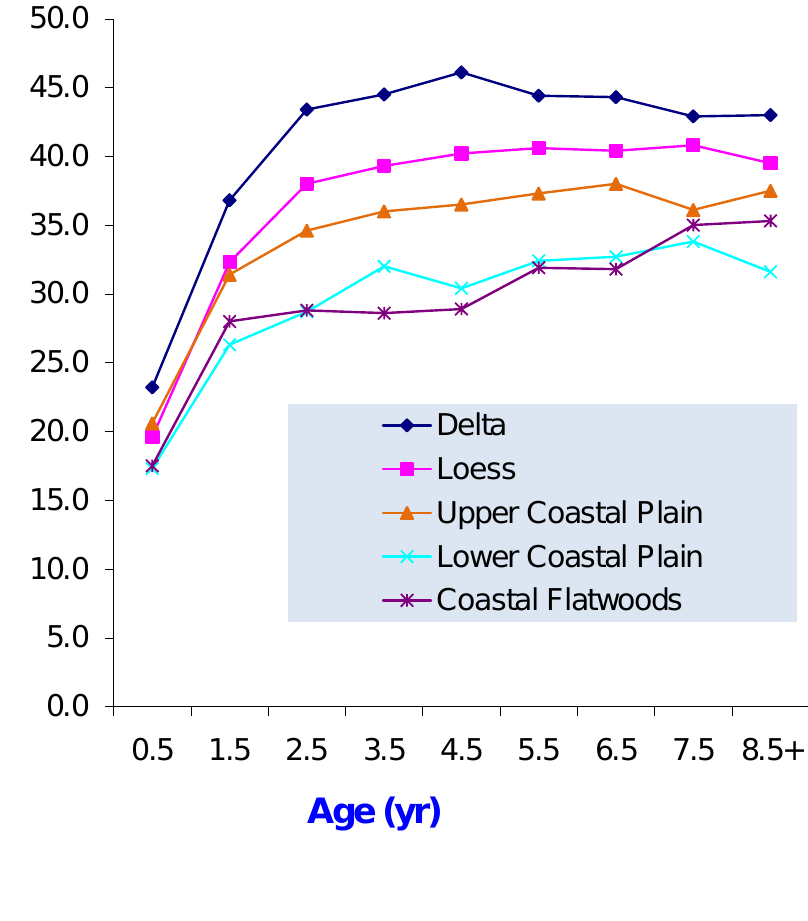
Figure 3. Female white-tailed deer body mass by soils in Mississippi herd health study during March 1991 –